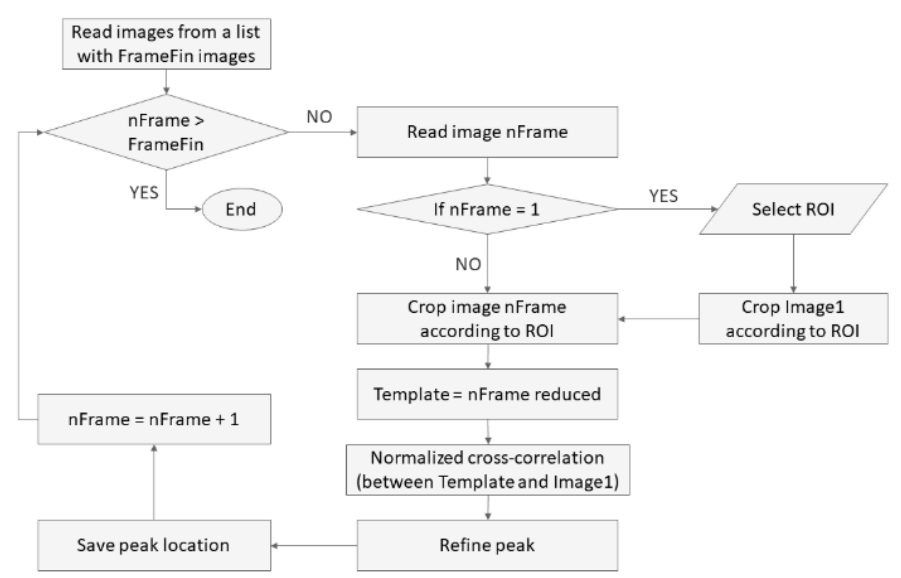
Figure 7. Flow chart for the image processing used in this work.